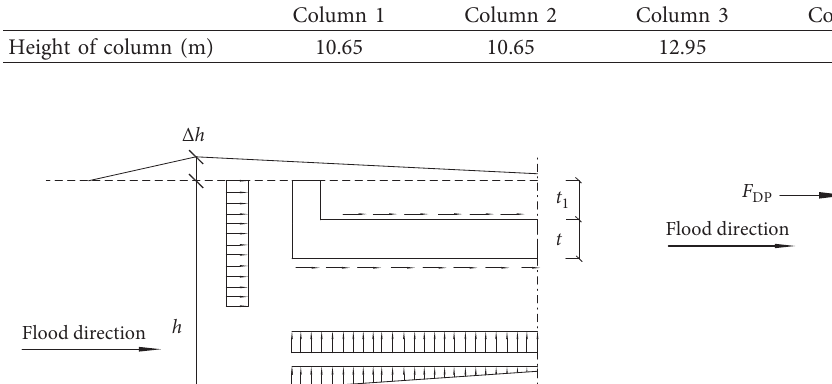
Figure 7: Simplified map of flood force